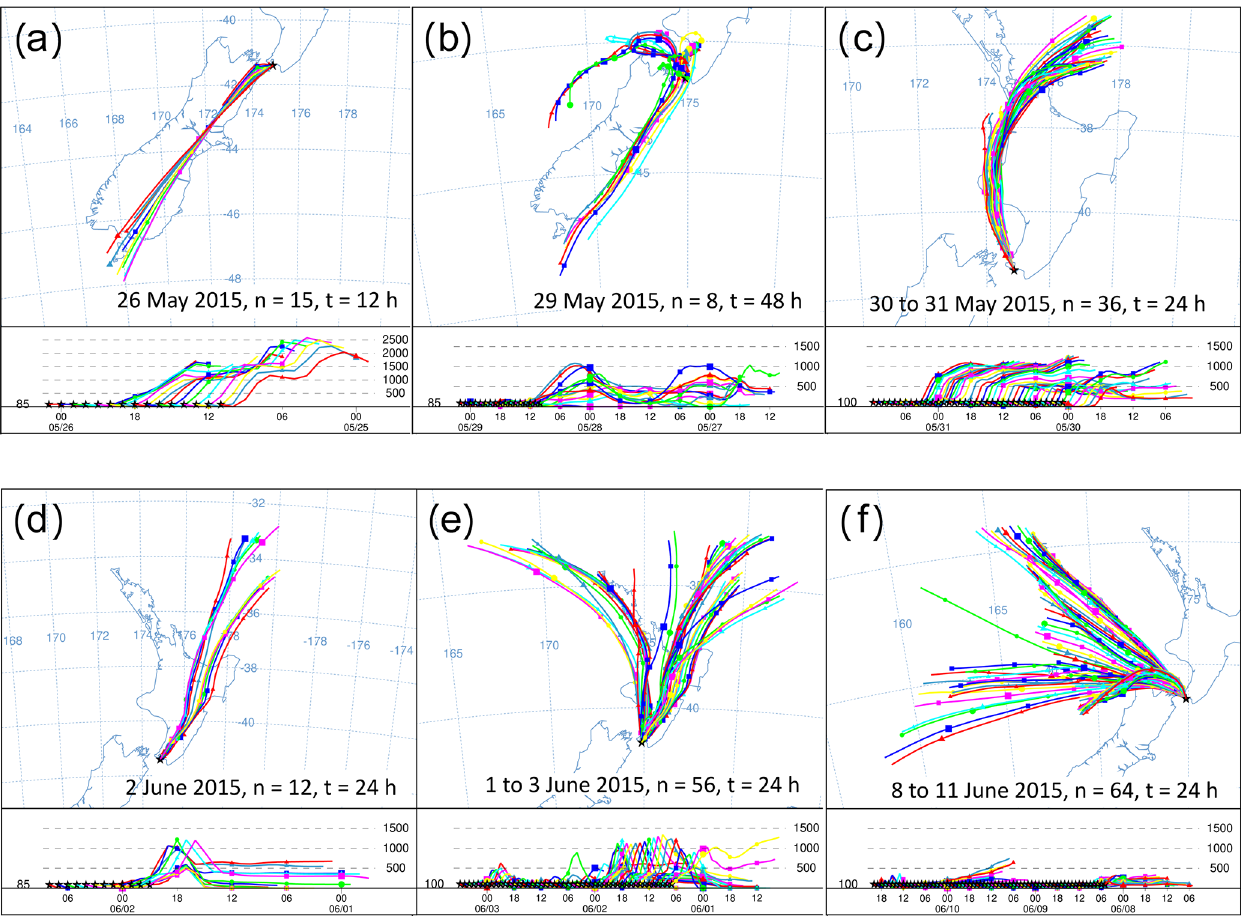
Figure 8. HYSPLIT back trajectories from six events in the Delta Ray time series. Each panel shows the history of air that was measured at the stated date. Intervals between trajectories are 1h, n indicates the number of trajectories in the panel and t represents the trajectory length in